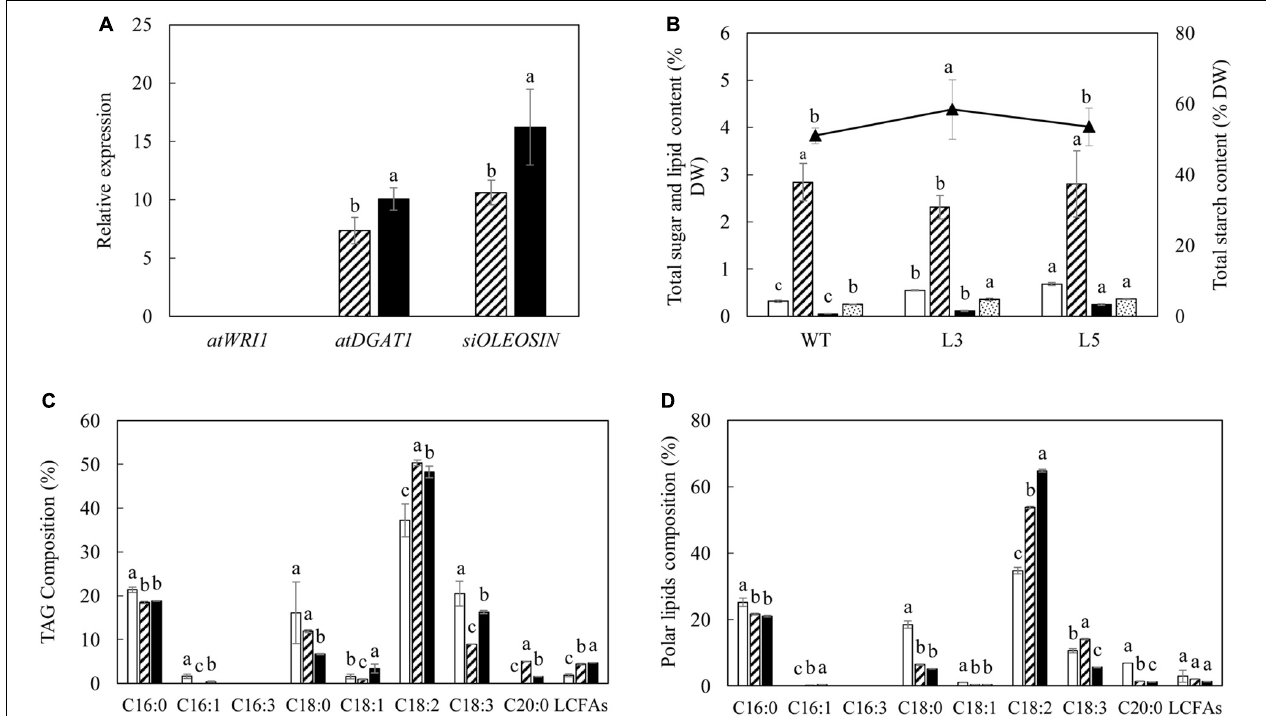
FIGURE 9 | Lipid and carbohydrate analysis in the mature potato tubers. (A) Real-time qRT-PCR analysis of the transgene expressions in L3 (bar with upward diagonal) and L5 (black bar); (B) Contents of TFA (open bar), total soluble sugars (bar with upward diagonal), total starch (triangle marker), TAG (black bar) and total polar lipid (bar with small confetti); (C) Fatty acid composition of TAG in WT (open bar), L3 (bar with upward diagonal) and L5 (black bar); (D) Fatty acid composition of total polar lipids in WT (open bar), L3 (bar with upward diagonal) and L5 (black bar). The data represent the mean values ± SD of three biological replicates. Letters (a, b, c, and d) above the bars are based on LSD, bars marked with different letters are statistically significantly different at P <